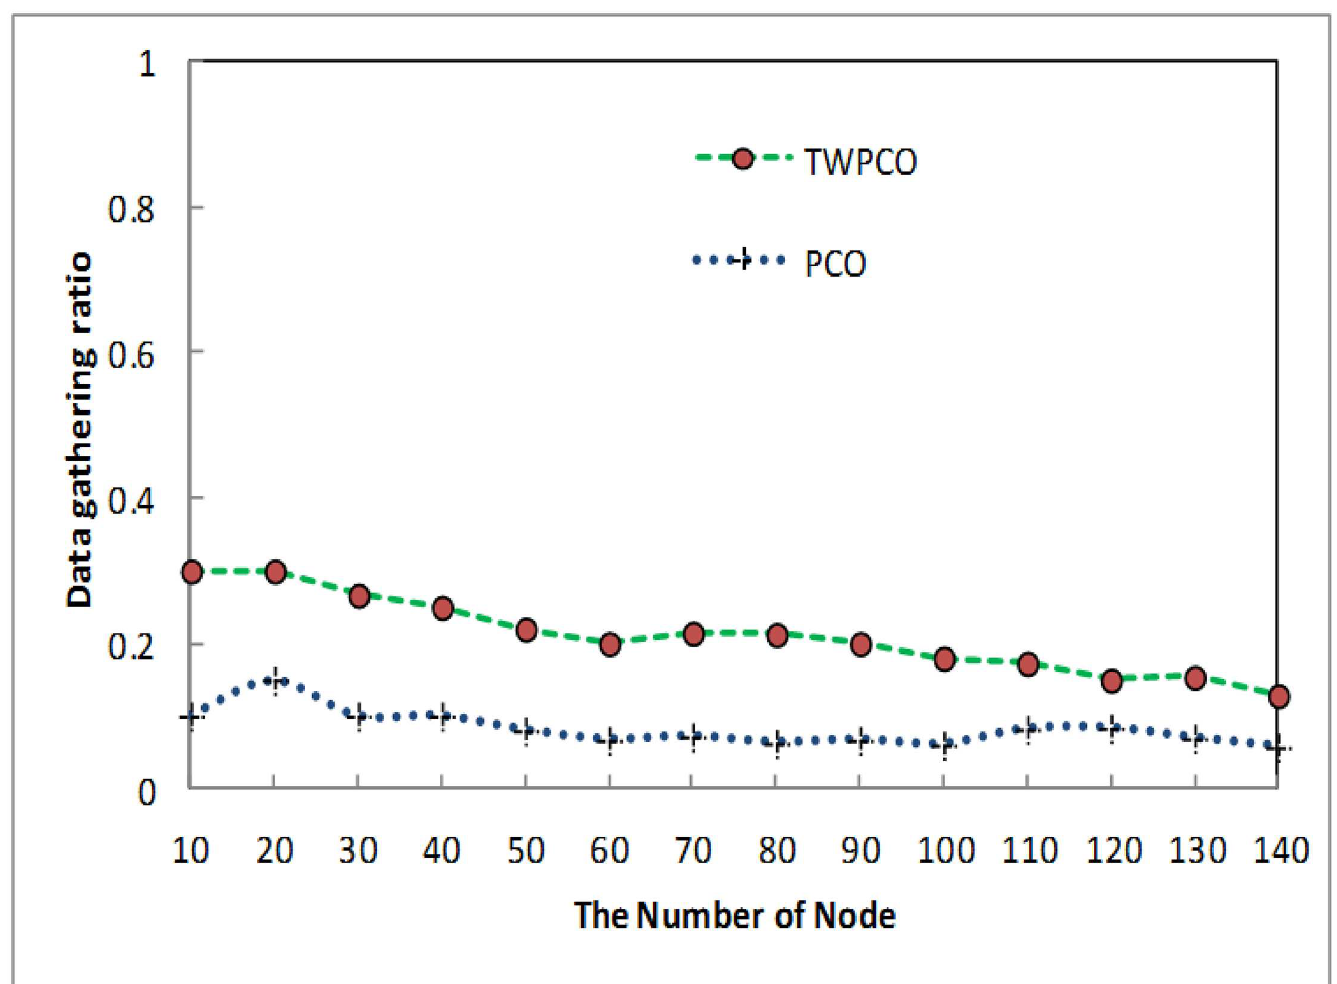
Fig 14. Data gathering ratio based on the number of nodes added and the number of sensor